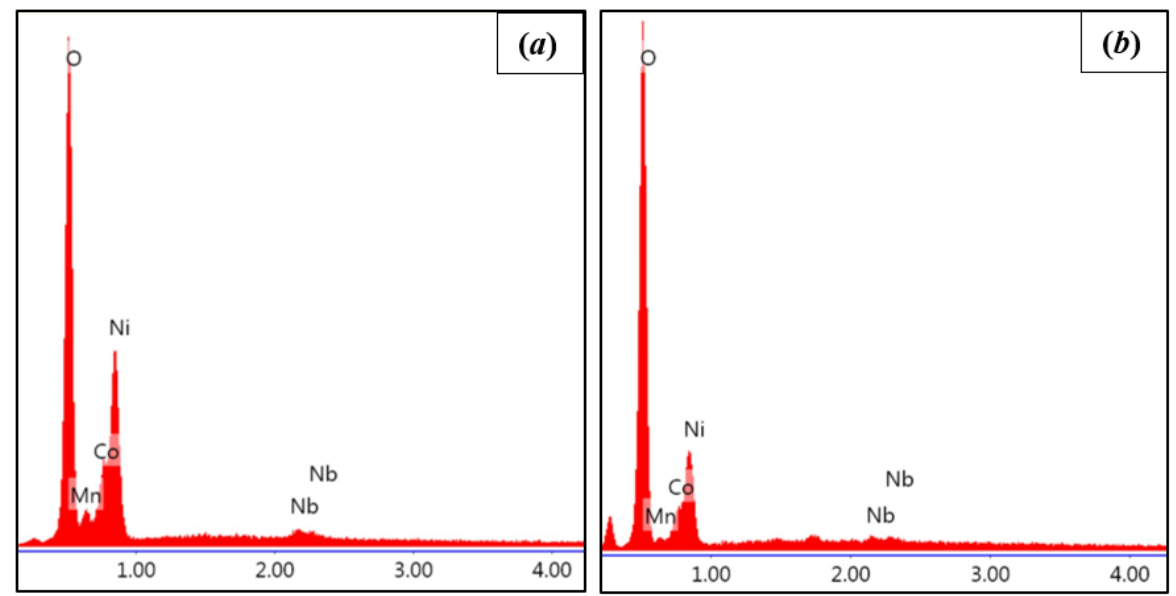
Figure 6. SEM imaging of ( a ) uncoated NMC-60, ( b ) Method-I-1%, and ( c ) Method-II-1% with inset exhibiting LNO as soft or feathery surface material in appearance.